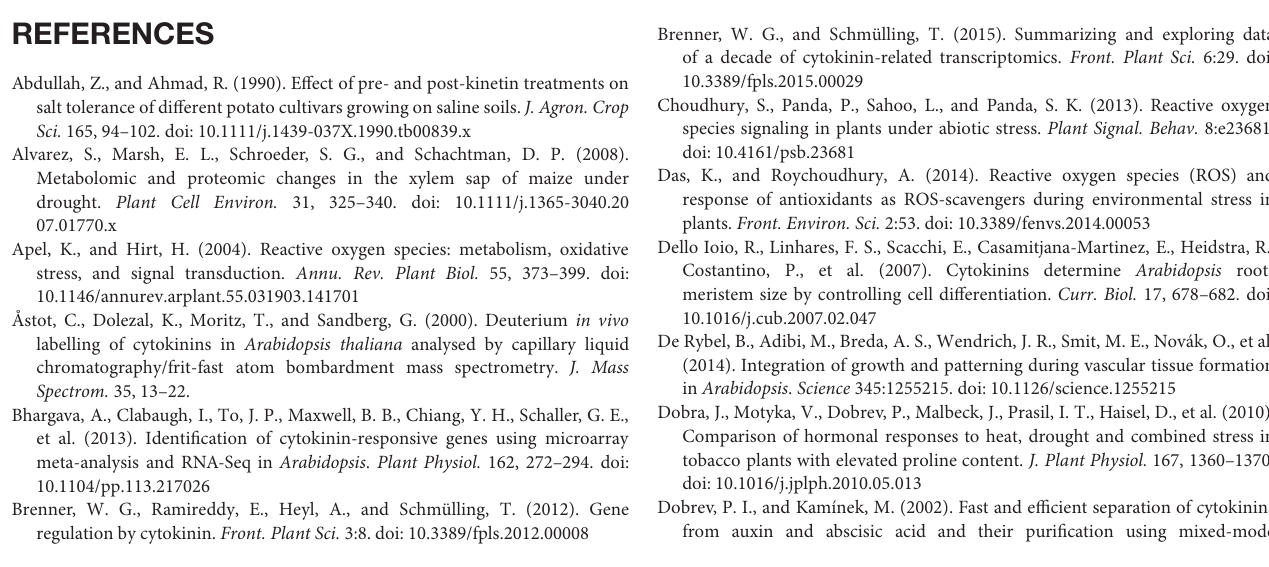
FIGURE S1 | The inhibited elongation of primary roots in OE2 can be rescued by IAA treatment. (A) Exogenously added IAA could rescue estradiol-induced aberrant growth of roots in OE2 . Seeds were growing on MS plates containing 17- β -estradiol (10 μ M) for 2 weeks, then transferred to medium containing IAA (1.0 nM) for 5 days. (Bar = 5cm). (B) The primary root lengths (shown in A ) were measured. The results represent the means + SE of three independent experiments (seedling numbers, n > 30 per experiment). (C) 17- β -estradiol (10 μ M) treatment could induce more callus generation in OE2 plants than that in Col under the same concentrations of exogenous 2,4-D (5 nM). Photos were taken after 7 days growth on MS plates. FIGURE S2 | Exogenous application of cytokinin (6-BA) enhanced ROS production under the condition of salt stress. (A) The 5-day-old Col seedlings were pretreated with NaCl (100 mM) plus or minus 6-BA (10 μ M) for 3 days. The fluorescent intensity of DCF was observed using the confocal microscope. Bar, 50 μ m. (B) The ROS contents in Col plants were quantified. The data are means ± SEs of three independent experiments ( n = 10). The fluorescent intensity of cotyledons in Col without salt treatment was taken as “1.” FIGURE S3 | Comparisons of differentially expressed genes in AtIPT8-OE plants and salt- and/or oxidative-stress regulated genes downloaded from public microarray database (http://bar . utoronto . ca/welcome . htm). (A) Hierarchical cluster analysis of genes affected by AtIPT8 overexpression, salt and oxidative stresses in Arabidopsis . The differentially expressed genes in OE2 plants after 17- β -estradiol (10 μ M) induction, and by the salt and oxidative treatments were analyzed by the method of using Cluster 3.0. The resulting tree figure was displayed using the Java Treeview software. The detailed information of genes was listed in Supplementary Table S2 . (B) Numbers of overlapping transcripts changed by cytokinin overproduction, salt and oxidative treatments. (C) Numbers of genes with up- or down-regulated expression levels by cytokinin overproduction, salt and oxidative treatments. TABLE S1 | Primers used for qRT-PCR analysis in this study. TABLE S2 | The differentially expressed genes in AtIPT8-OE plant and ROS-regulated and/or salt-regulated genes from public microarry data (http://bar . utoronto . ca/welcome .